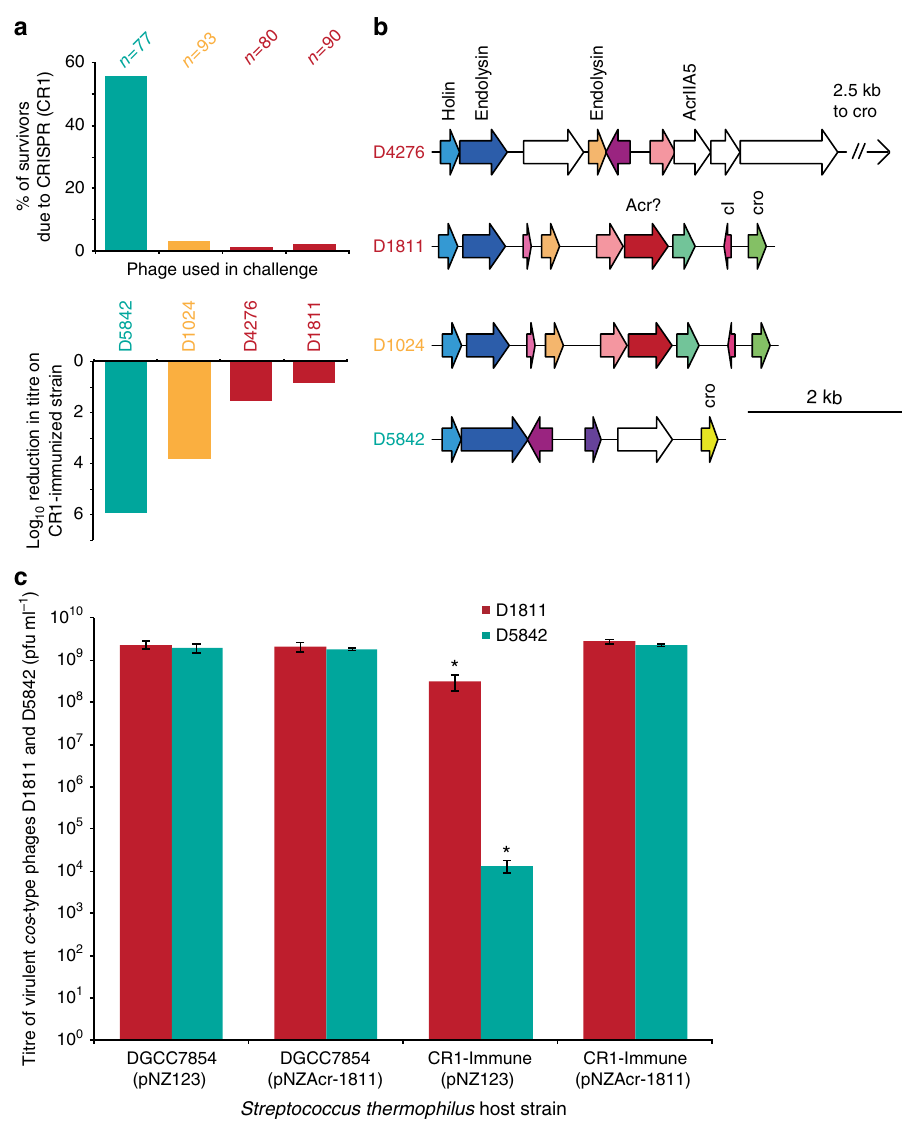
Fig. 1 Discovery of a new Acr. a Pro fi les of immunity generation (top, where n = the number of survivors screened) and ability to bypass immunity (bottom) of CRISPR-sensitive (green), CRISPR-resistant (red), and CRISPR-intermediate (ochre) phages. Log reductions from three technical replicates. b Representation of the genomic region in which acrIIA5 was found in D4276 for each phage in a . ORFs, represented by an arrow, are color-coded if their product shares >50% aa identity with another elsewhere in any of the other phages, and white if it does not. Functions are annotated for the fi rst instance of any ortholog. “ Acr? ” was investigated for being downstream of a gene (pink) conserved in D4276. c Titres of a CRISPR-sensitive (green) or CRISPR- resistant (red) phage on their host or a CR1-immunized version thereof, in the presence or absence of the putative Acr. The presence of the Acr restores the titre of both phages to the levels observed in the absence of immunity. The titres are from three biological replicates, each of three technical replicates. Error bars represent standard deviation, and a star (*) indicates a signi fi cant difference from each other column in the graph, as calculated by one-way analysis of variance (ANOVA) and Tukey honest signi fi cant difference (HSD) test ( p <